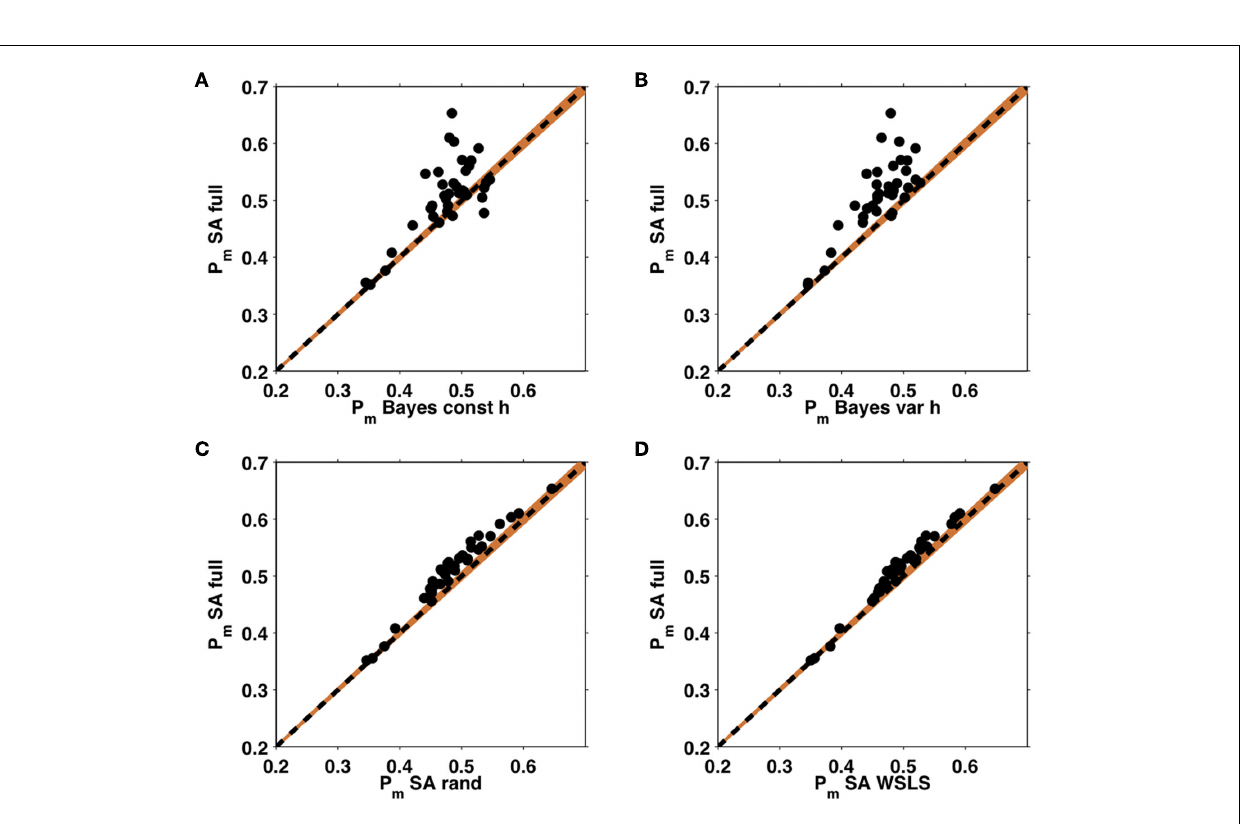
subject, the black dashed line indicates equality, such that the choices of any subject lying above this line are better explained by the full selective attention model. Orange shading represents a confidence interval outside which the Bayesian evidence favors one model over the other with p <